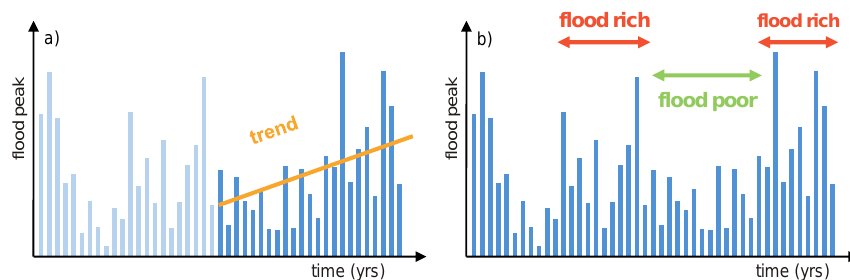
Figure 7. Evaluation of flood peak changes over time. (a) Monotonic trend analysis; (b) identification of flood-rich and flood-poor periods. Dark blue colour indicates data available for